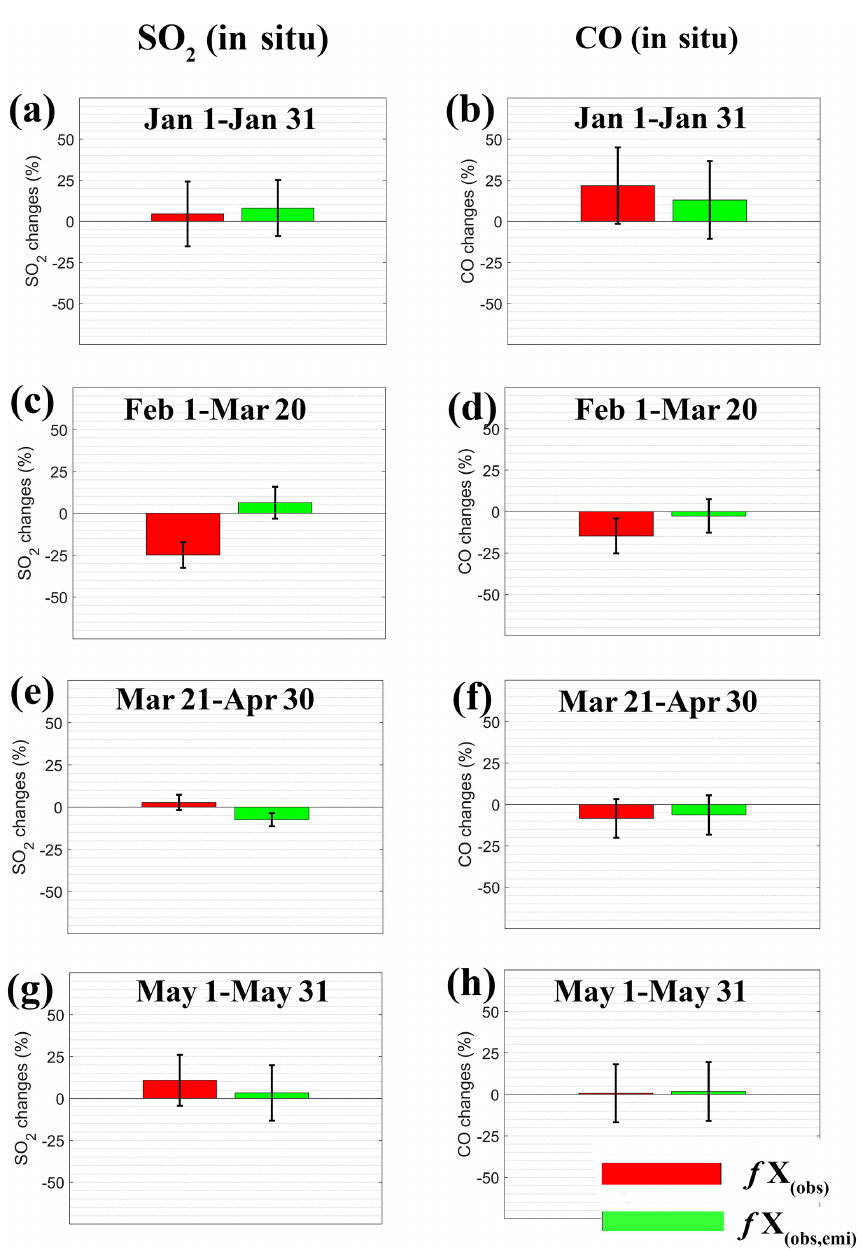
Figure B1. Mean changes in in situ SO 2 (Bremen, Dresden, Frankfurt, Hamburg, and Leipzig) and in in situ CO (Bremen, Frankfurt, Hamburg, Hanover, Munich, and Stuttgart) with meteorology accounted for (green) and unaccounted for (red) between 2020 and 2019. Error bars represent the 1 σ of the mean of the abovementioned metropolitan